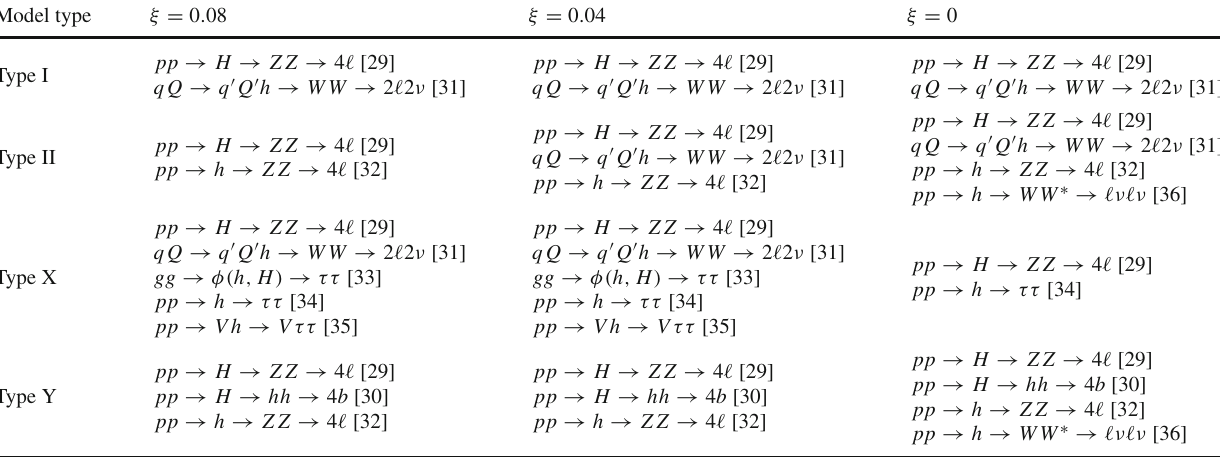
Table 2 Higgs search channels most responsible for excluding parameter points in Fig. 1 Model type